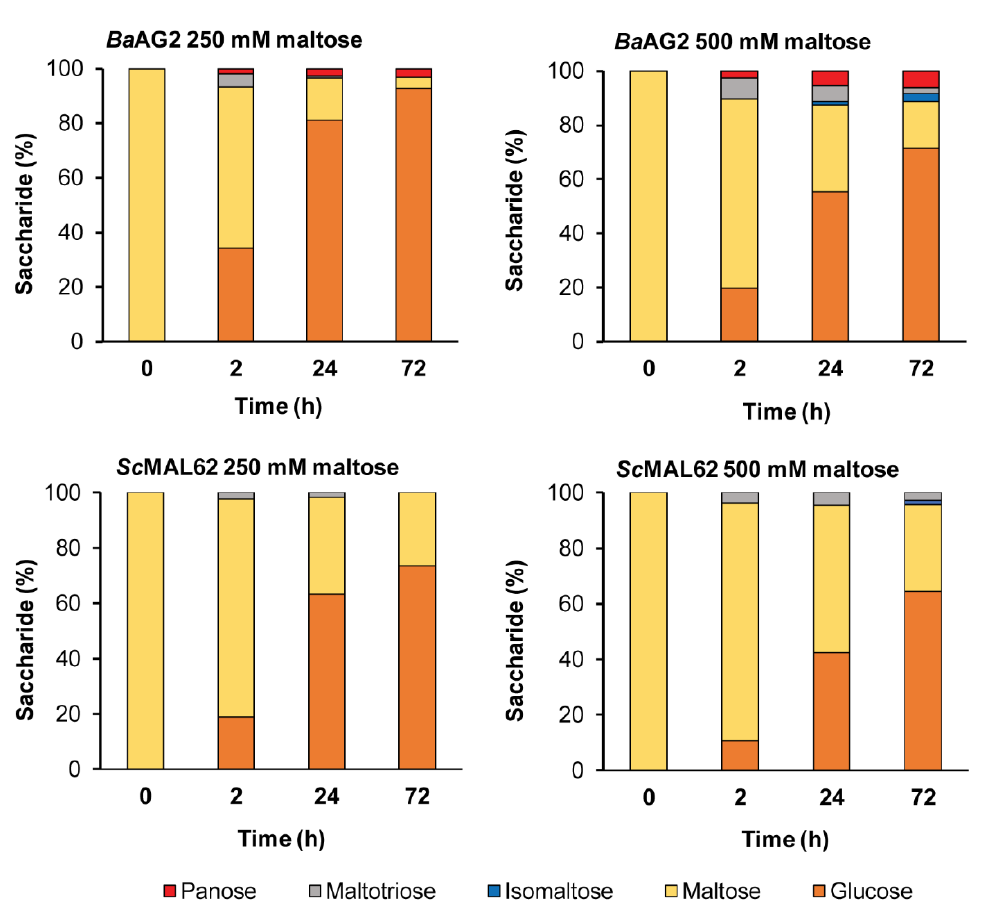
Figure 8. Transglycosylation of maltose by Ba AG2 and Sc MAL62. 20 µ g / mL of the enzyme was reacted with 250 mM or 500 mM of maltose. Samples from the reaction mixtures were withdrawn at designated time points, heated to terminate the reaction and analyzed for sugar composition by HPLC as described in Materials and Methods, paragraphs 4.5. and 4.6. Total amount of detected saccharides at each time point was equalled to 100%. Products were identified using glucose, maltose, isomaltose, maltotriose and panose as references. SDs of two to three HPLC measurements at each time point were up to